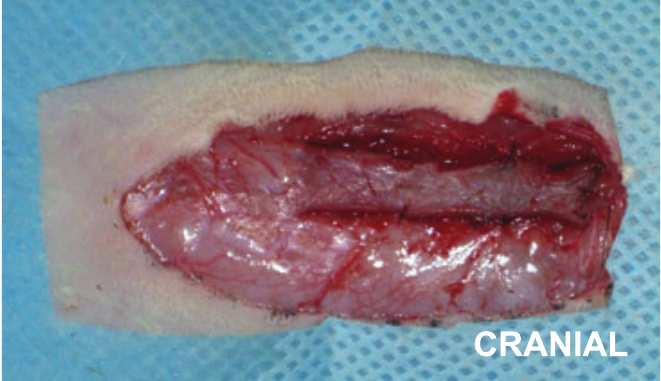
FIGURE 3 – Group D - anterior abdominal wall of rat displaying cranial devascularization of the right rectus abdominis muscle, sutured in its bed after the muscle was reflected in the craniocaudal direction.